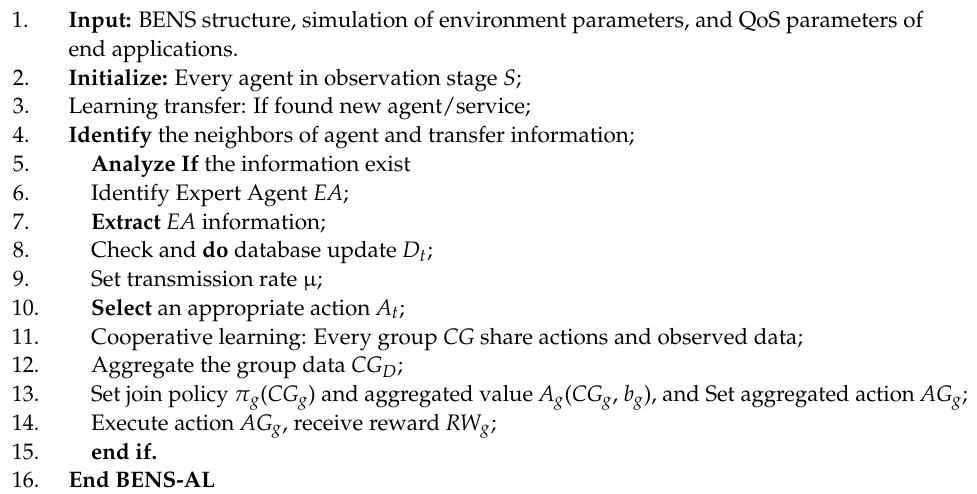
Algorithm 2. BENS-Agent Learning Algorithm